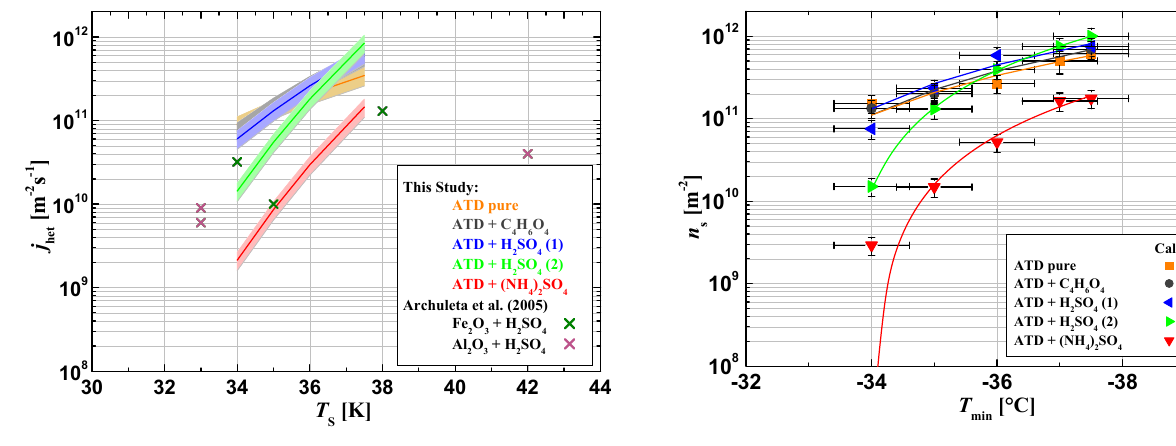
Fig. 10. Nucleation rates j het for all types of particles. For the determination of j het , the values for a and f het are inserted into Eq. (4) and all types of IN are assumed to be spherical with a volume equivalent diameter of 300nm. The crosses represent nucleation rates for sulfuric acid coated iron and aluminium oxide particles determined by Archuleta et al. (2005).